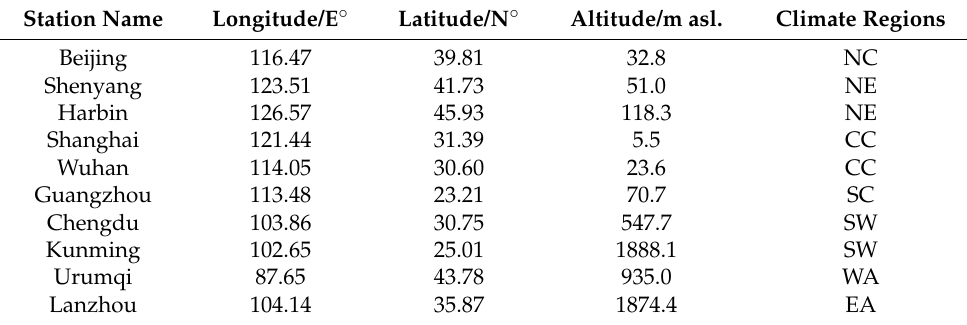
Figure 1. Locations of the ten investigated stations and their climate conditions. NC for North China, NE for Northeast China, CC for Central China, SC for South China, SW for Southwest China, EA for Eastern arid regions, WA for Western arid/semi-arid regions, TP for the Tibetan plateau. Table 1. Geographical information of the investigated stations used in this study.